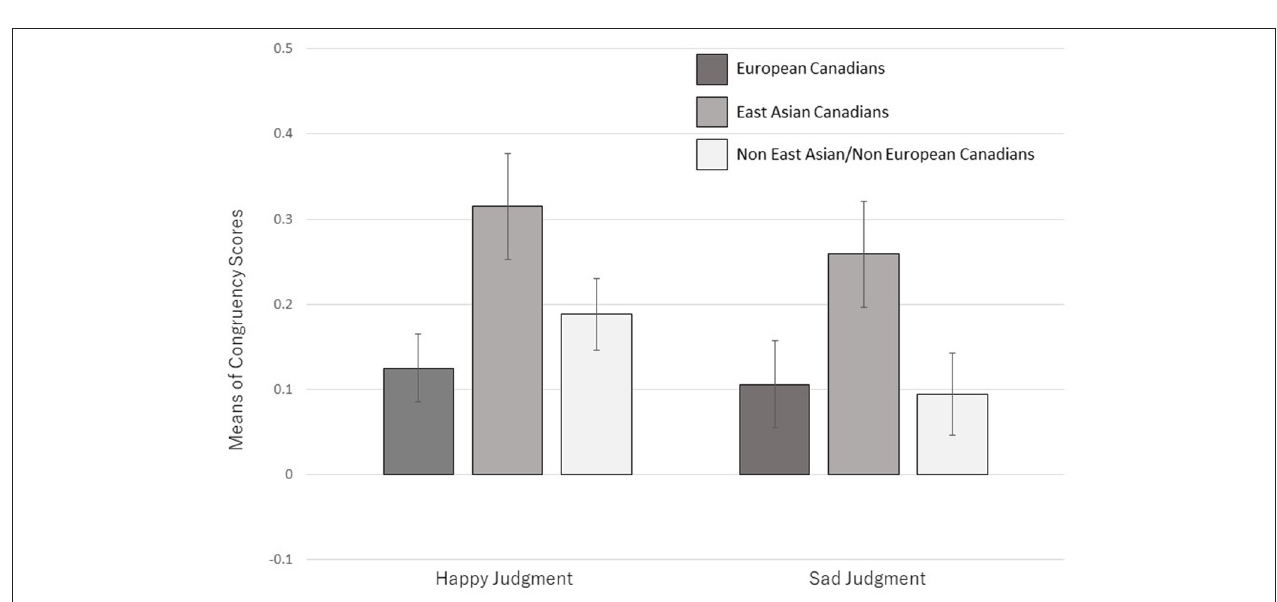
FIGURE 3 | Comparison of congruency scores for the happy judgment and the sad judgment between the three cultural groups: European Canadians, East Asian Canadians, Non East Asian/Non European Canadians.